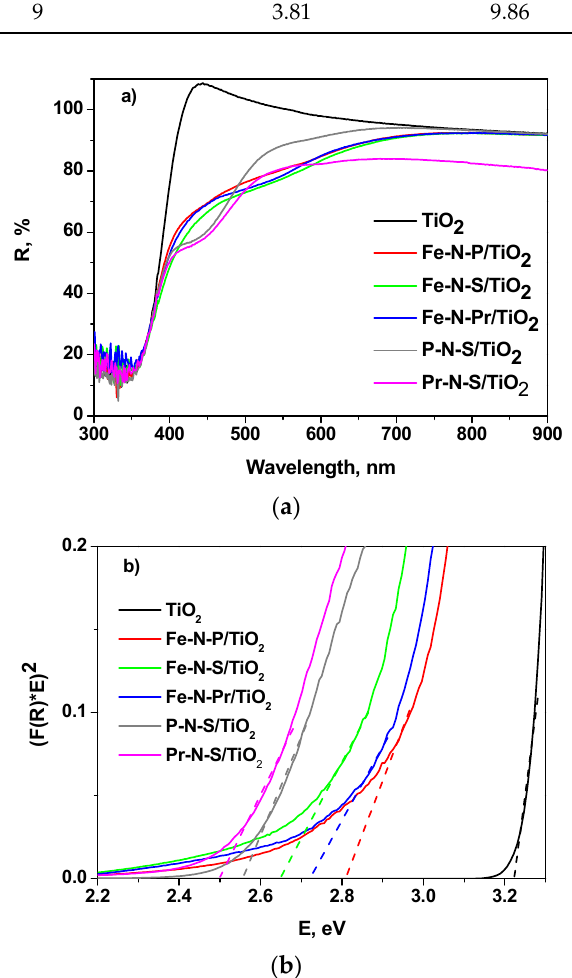
Figure 1. ( a ) UV-vis DRS spectra and ( b ) band-gap evaluation of all prepared samples. The main absorption of the un-doped TiO 2 is located in the UV-A region, and no absorption is detected in the visible region. The Fe-N-P/TiO 2 , Fe-N-S-TiO 2 , and Fe-Pr-N- TiO 2 samples exhibit similar absorption performances in the range 450–600 nm, probably due to the presence of dopant elements into TiO 2 lattice [25,26]. Both Pr-N-S/TiO 2 and P-N-S/TiO 2 sample absorption spectra present a shoulder in the visible region. Band